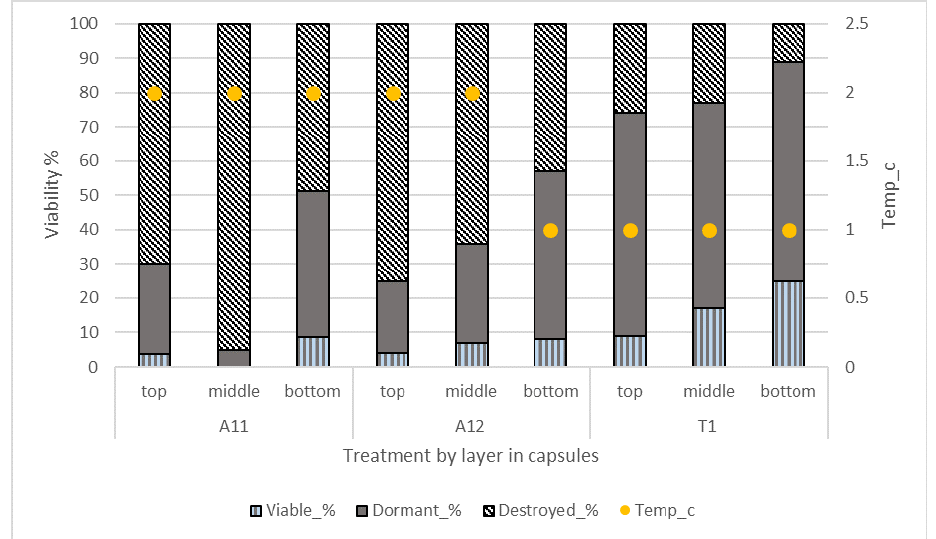
Figure 4. Proportion of viable, dormant and destroyed L. polyphyllus Lind. seed after windrow (A11, A12) and tunnel (T1) composting (bars) showing average temperature classified as mesophilic (1) and thermophilic (2).